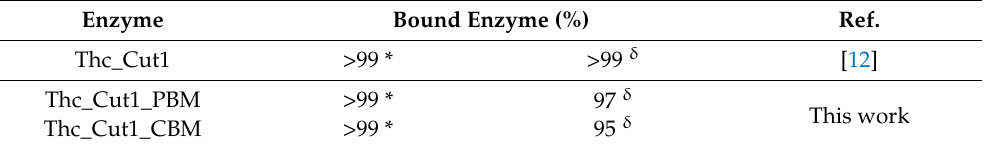
Enzyme Bound Enzyme (%)